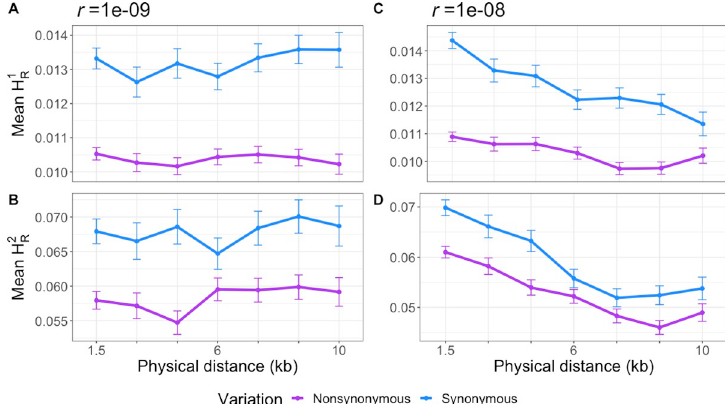
Fig 2. Distribution of mean H R(1) and H R(2) across simulated data with different recombination rates and selection coefficients of NS mutations drawn from a DFE. Forward simulations predict NS pairs of variants have a mean H R(j) that is on average lower than that of S pairs of variants. (A) H R(1) for simulations with a low recombination rate ( r = 1 x 10 − 9 per bp). (B) H R (2) for simulations with a low recombination rate. (C) H R (1) for simulations with an average recombination rate ( r = 1 x 10 − 8 per bp). (D) H R(2) for simulations with an average recombination rate. Each point is the mean H R(j) statistic in a 1.5kb wide distance bin. Error bars represent one standard error of the mean. 4,300 simulation replicates of Model 2 were simulated for each recombination